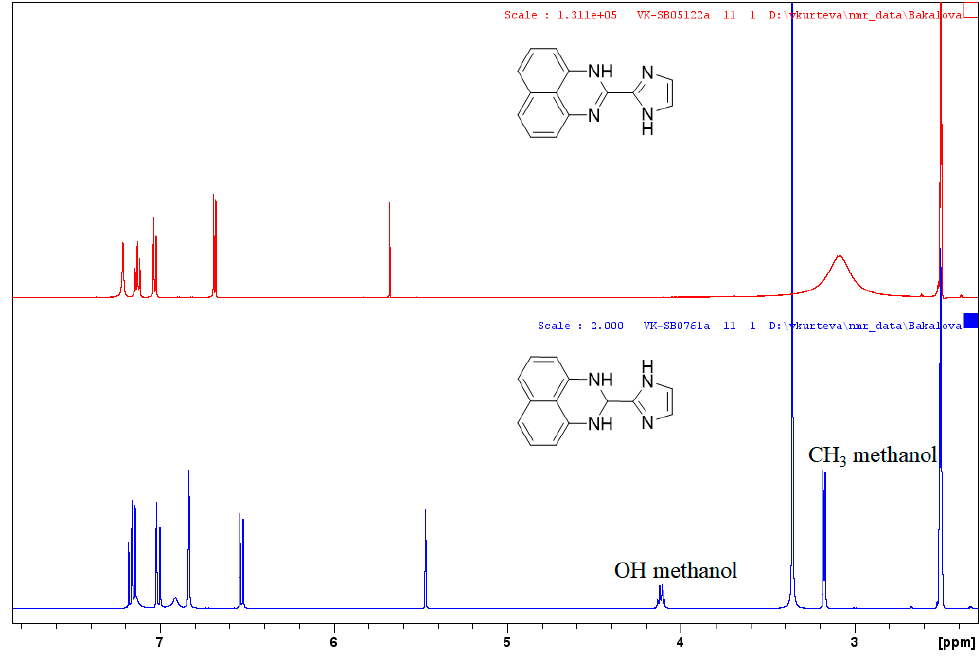
Figure 5. 1 H NMR spectra of 2-(1H-imidazol-2-yl)-2,3-dihydro-1H-perimidine (down) and 2-(1H-